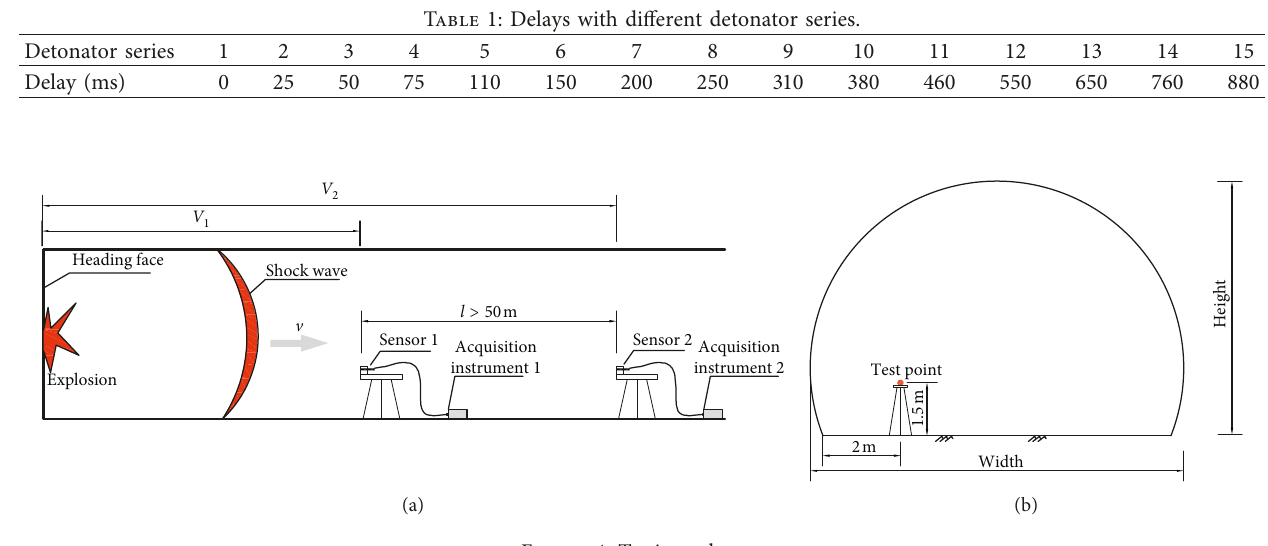
Figure 4: Testing